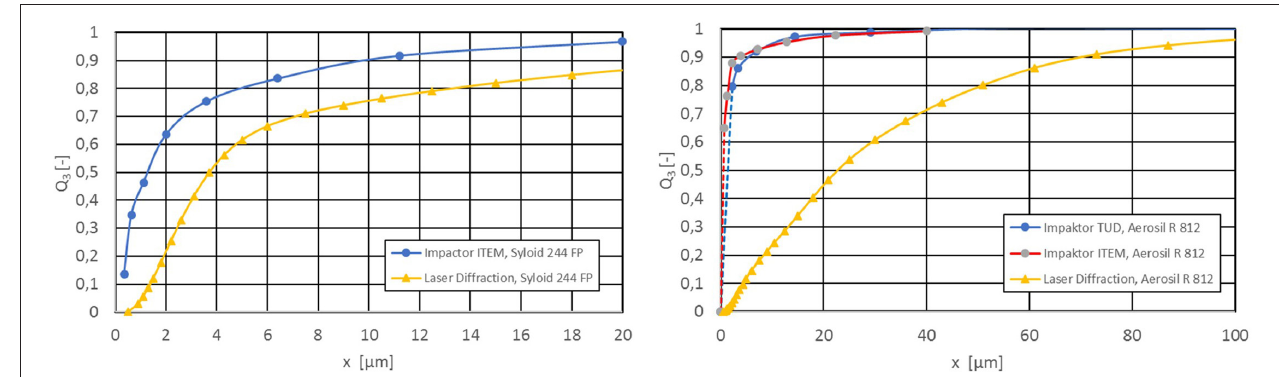
FIGURE 4 | PSD - Comparison of cascade impactor and laser diffraction after an operating time of 3h 50 min: left: silica gel, 500 mg/m 3 , ρ eff = 242 kg/m 3 ; right: surface-treated pyrogenic silica, c m = 500 mg/m 3 , ρ eff = 64 kg/m 3 (tamped density).